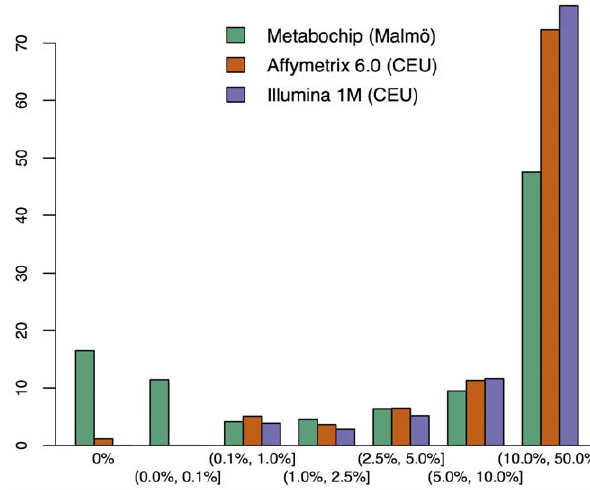
Figure 2. Distribution of minor allele frequencies on the Metabochip, the Affymetrix 6.0, and the Illumina 1 M. Same comparison as in Figure 1, except that in this figure the minor allele frequencies on the Metabochip are determined from the Malmo¨, Sweden, sample while those on the Affymetrix 6.0 and Illumina 1 M GWAS arrays are determined from the HapMap CEU sample.